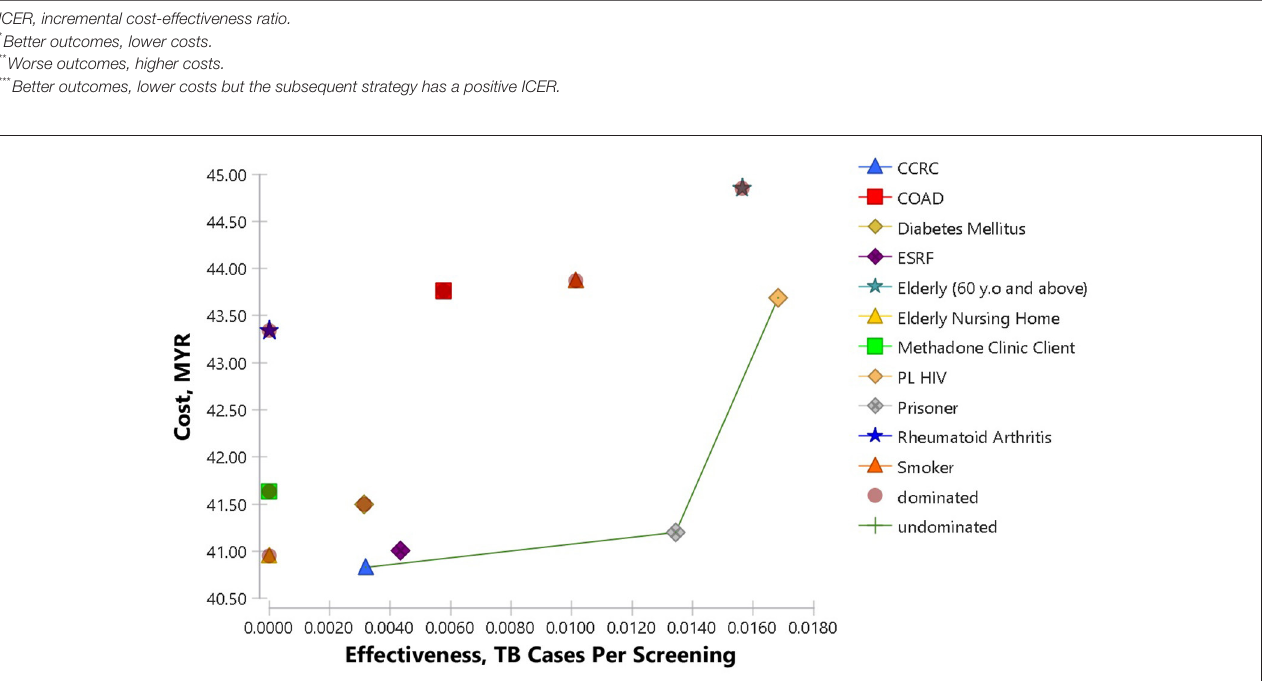
FIGURE 2 | Cost-effectiveness Plane of TB screening among high-risk groups. The frontier is made up of CCRC, prisoners and PL HIV. The cost-effectiveness plane visualizes each strategy effectiveness and cost in relation to the